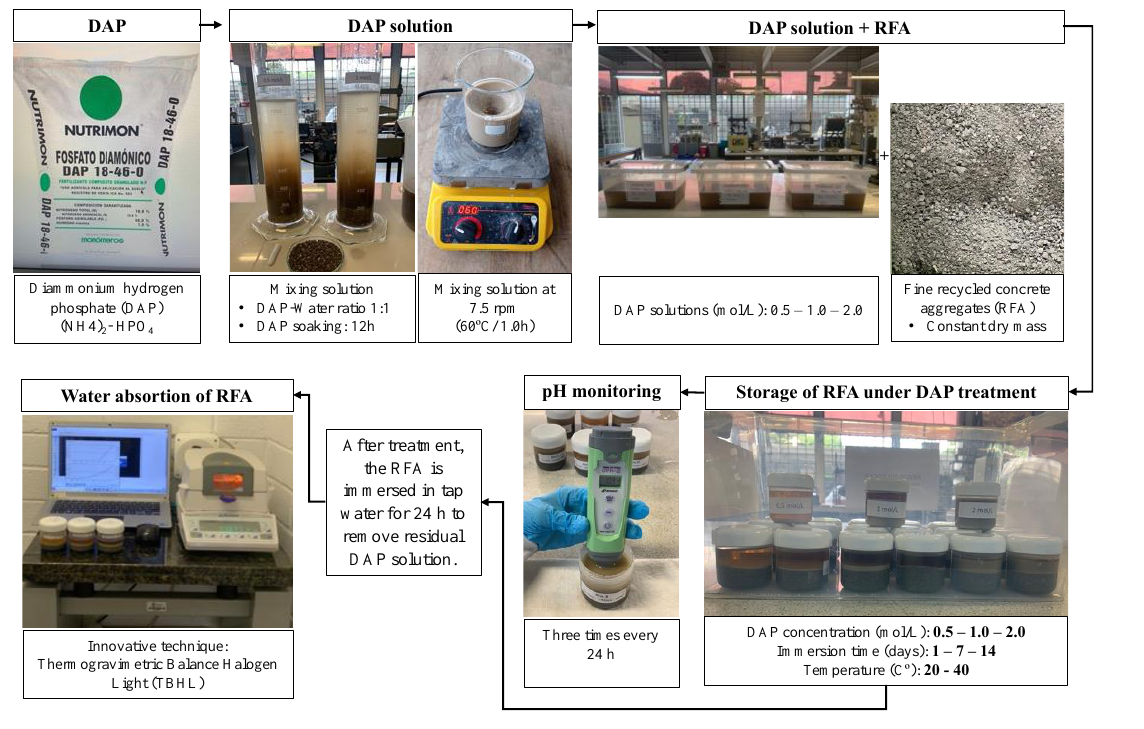
Figure 4. DAP treatment process. Table 2. Water absorption value for RFA.